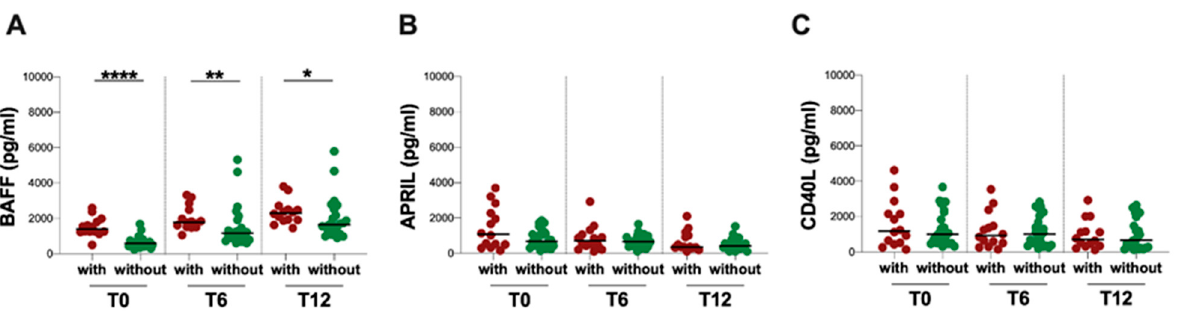
Figure 5. Evaluation of plasma BAFF, APRIL and CD40L levels in pwMS stratified according to the occurrence of infectious event. ( A ) Evaluation of plasma BAFF levels at T0, T6 and T12 between the with and without infectious event subgroups. ( B ) Evaluation of plasma APRIL levels at T0, T6 and T12 between the with and without infectious event subgroups. ( C ) Evaluation of plasma CD40L levels at T0, T6 and T12 between the with and without infectious event subgroups. BAFF: